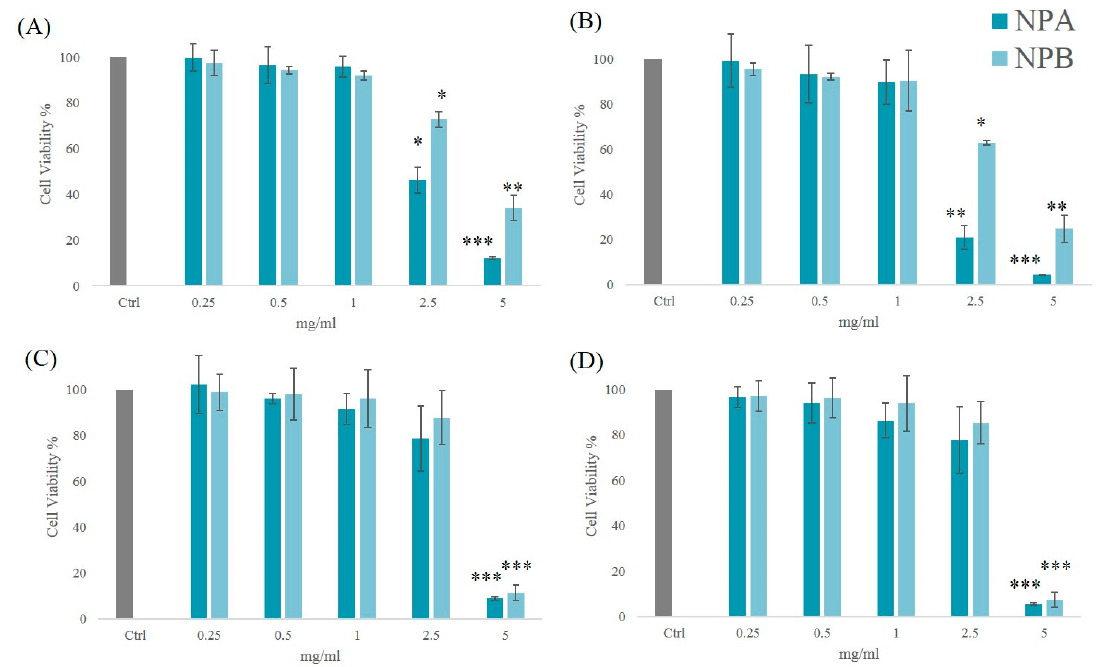
Figure 1. Cytotoxicity of NPA and NPB NPs on primary endothelial cells after 24 ( A ) and 48 ( B ) hours of incubation and on primary retinal pericytes cells after 24 ( C ) and 48 ( D ) hours of incubation at different concentrations (5; 2.5; 1; 0.5; 0.25 mg/mL). Three independent experiments were performed in sixfold. Error bars depict the S.D. of the mean. T-test was used to calculate statistical significance of the percentages obtained versus control group. [ns = not significant ( p > 0.05); * = significant ( p < 0.05); ** = very significant ( p < 0.01); *** = extremely significant ( p < 0.001)].